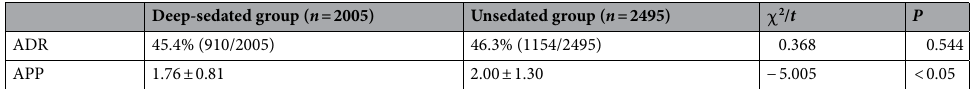
Table 2. Comparison of ADR and APP between deep-sedated group and unsedated group. ADR adenoma detection rate, APP adenomas per positive